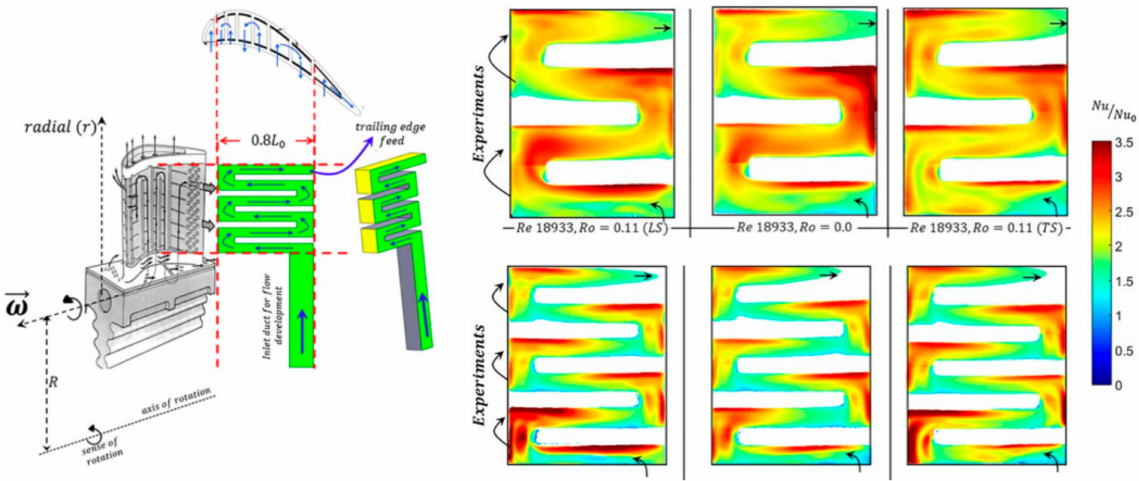
Figure 18. Parallel rotation multi-passage cooling scheme proposed by Singh et al. [71]. Reprint with permission from ASME (order number 1085964).